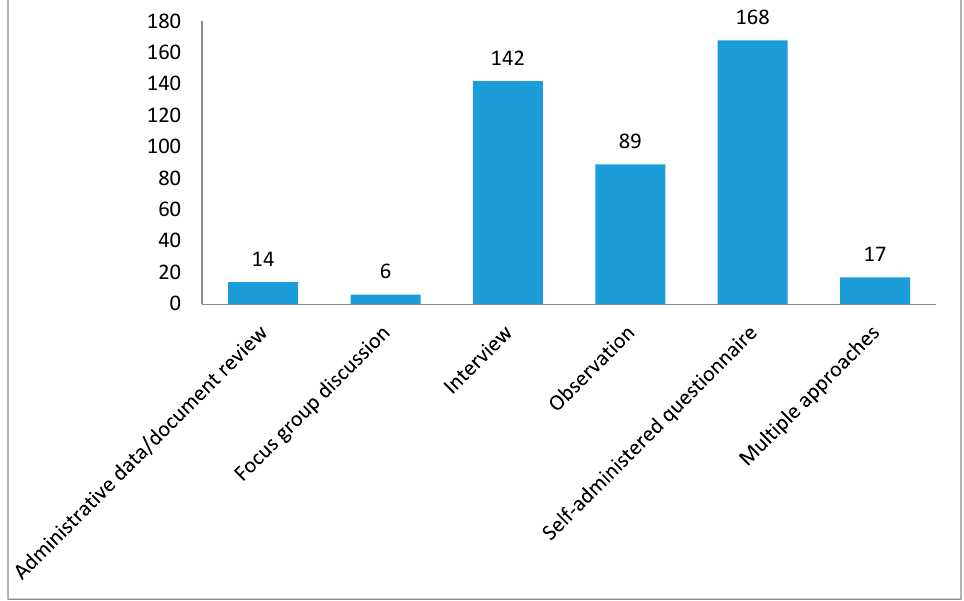
Figure 5. Type of Data used for Tobacco Control Research in SSA (up to February 2017; n = 436). Note: